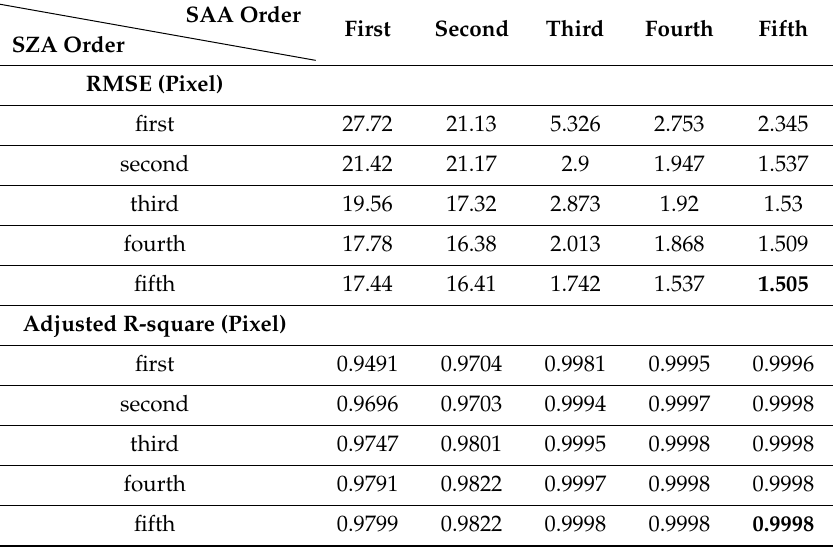
Table 2. Results of the optimal column coordinate transformation.